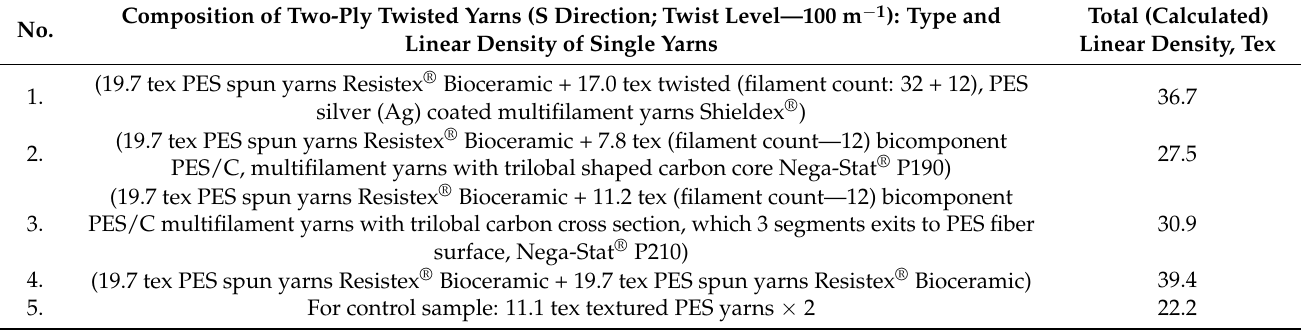
Table 1. The main characteristics of the two-ply twisted yarns of the new